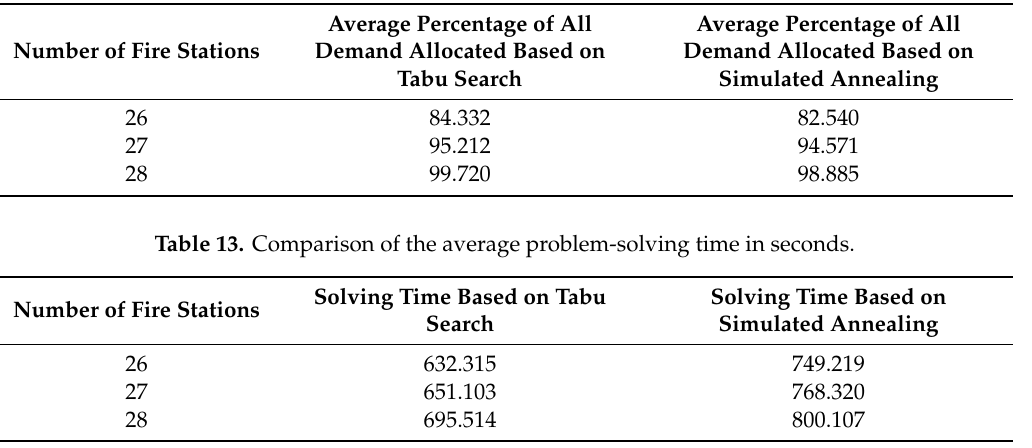
Table 12. The average percentage of demand allocated using both algorithms.